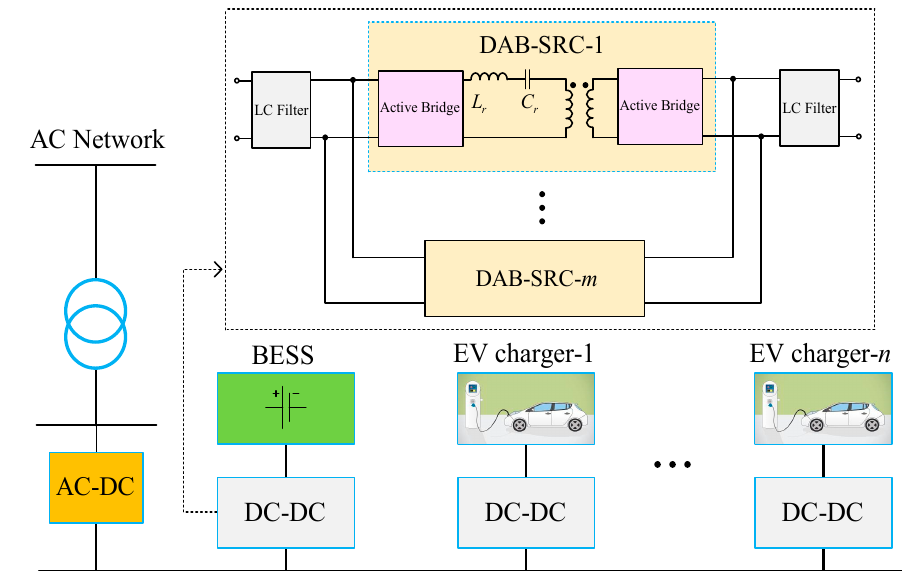
Figure 1. An electric vehicle (EV) charging station with n -number of charging stages, while each stage comprises of m -number of paralleled dual-active bridge series resonant converters (DAB-SRCs).